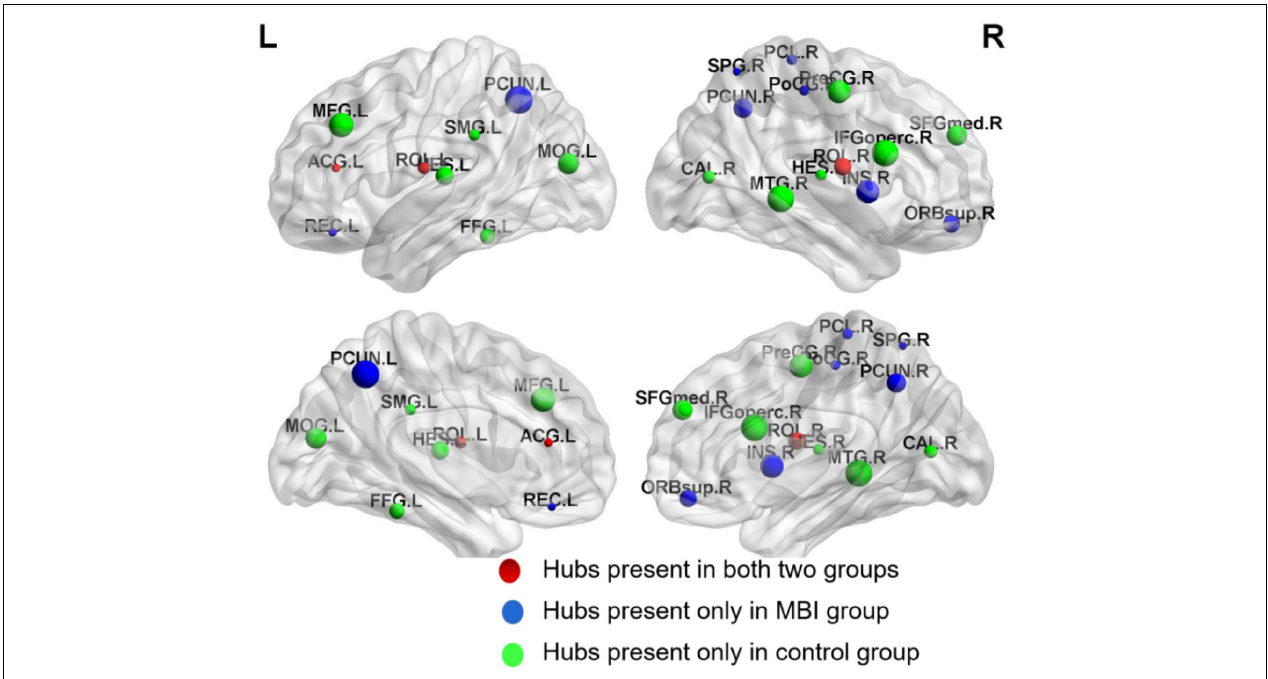
FIGURE 4 | Network hubs in normal controls and MBI patients. Red color represents common network hubs in both groups, blue color represents hubs only in MBI group, and green color represents hubs only in control